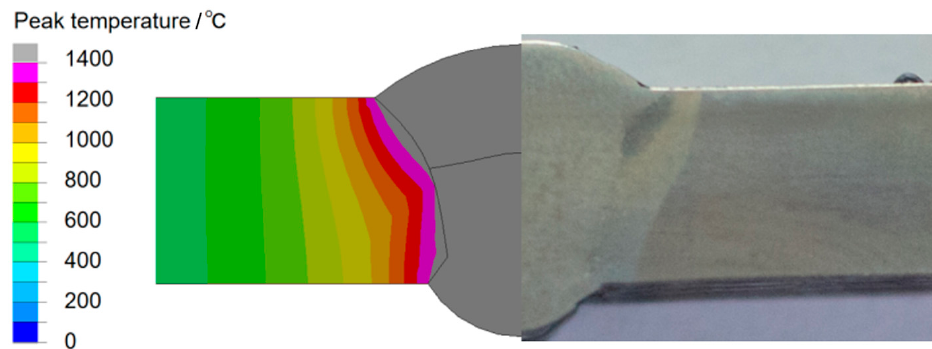
Figure 12. Computational and experimental fusion zone.